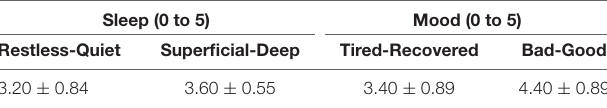
TABLE 3 | Subjective sleep quality.